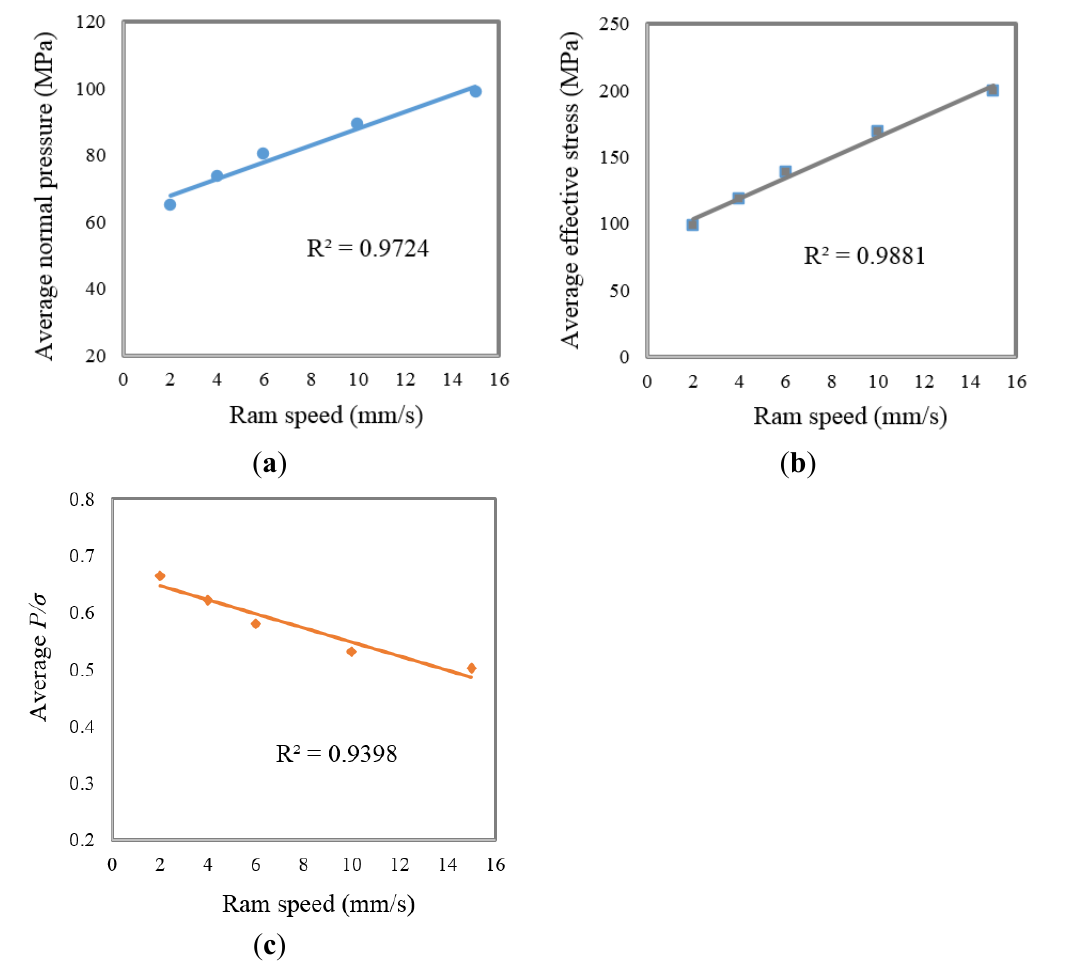
Figure 8. ( a ) Average normal pressure; ( b ) Average effective stress; ( c ) Average P / σ versus ram